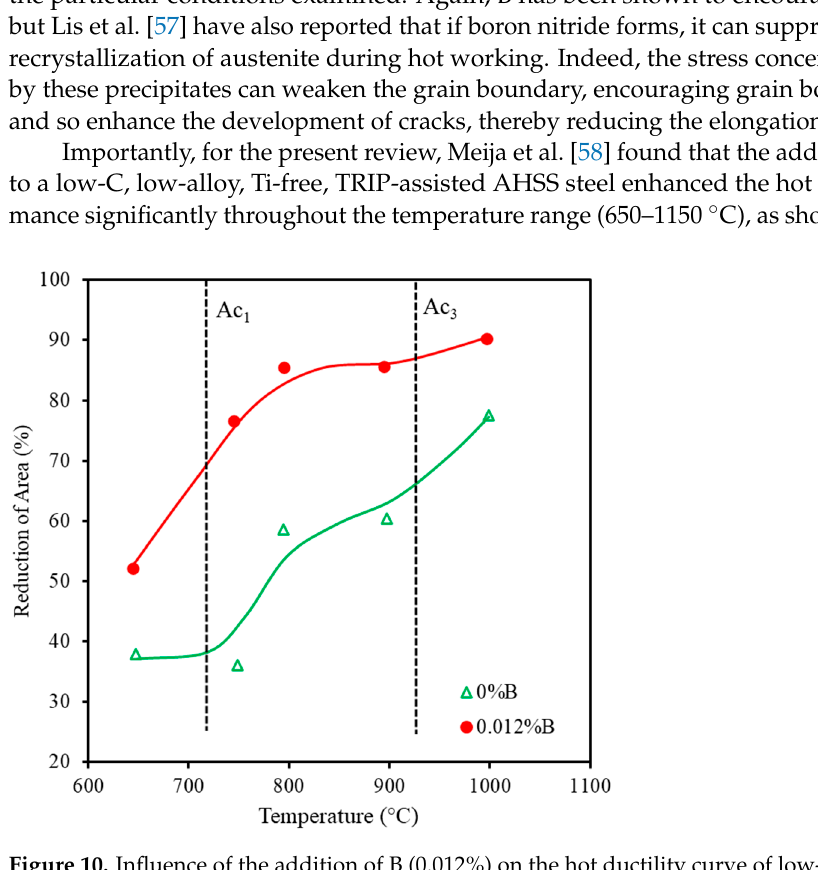
Figure 10. Influence of the addition of B (0.012%) on the hot ductility curve of low-carbon advanced high-strength steels (AHSS). The base composition of the steel was 0.06% C, 0.35% Mn, 0.3% Si, 2.2% Ni, 1.2% Cr, 0.5% Cu, 0.2% V, and 0.006% N, and was Ti-free [58]. Adapted from [58], with permission from Elsevier, 2023.